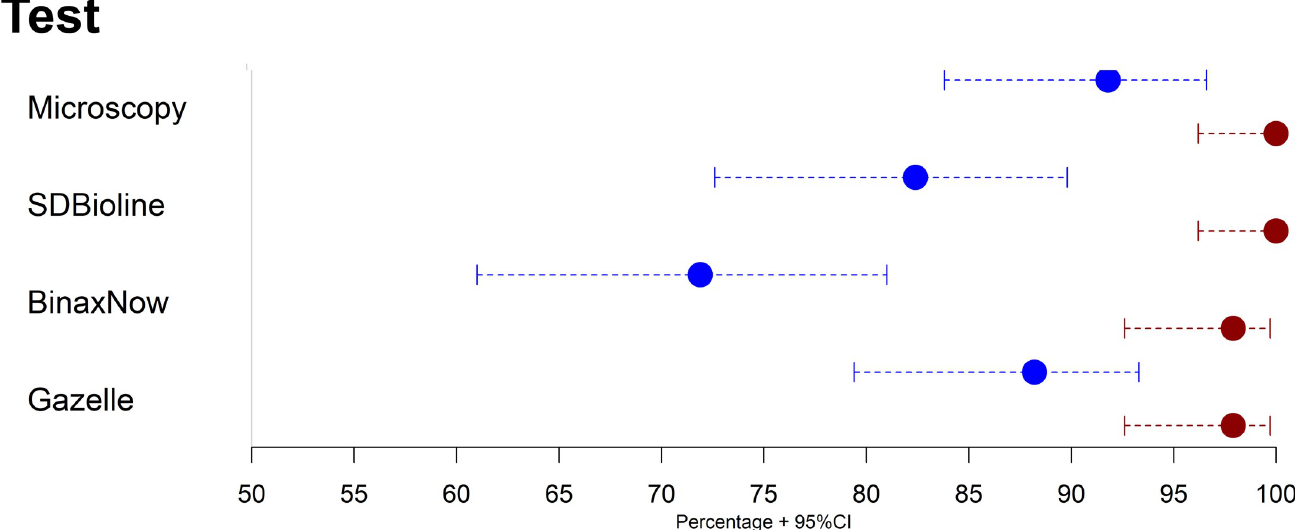
Fig 3. Sensitivity (blue dots), specificity (red dots) and 95% confidence intervals for detection of malaria by microscopy, SD Bioline, BinaxNOW and Gazelle in P . vivax using 18S rRNA-nested PCR as reference.